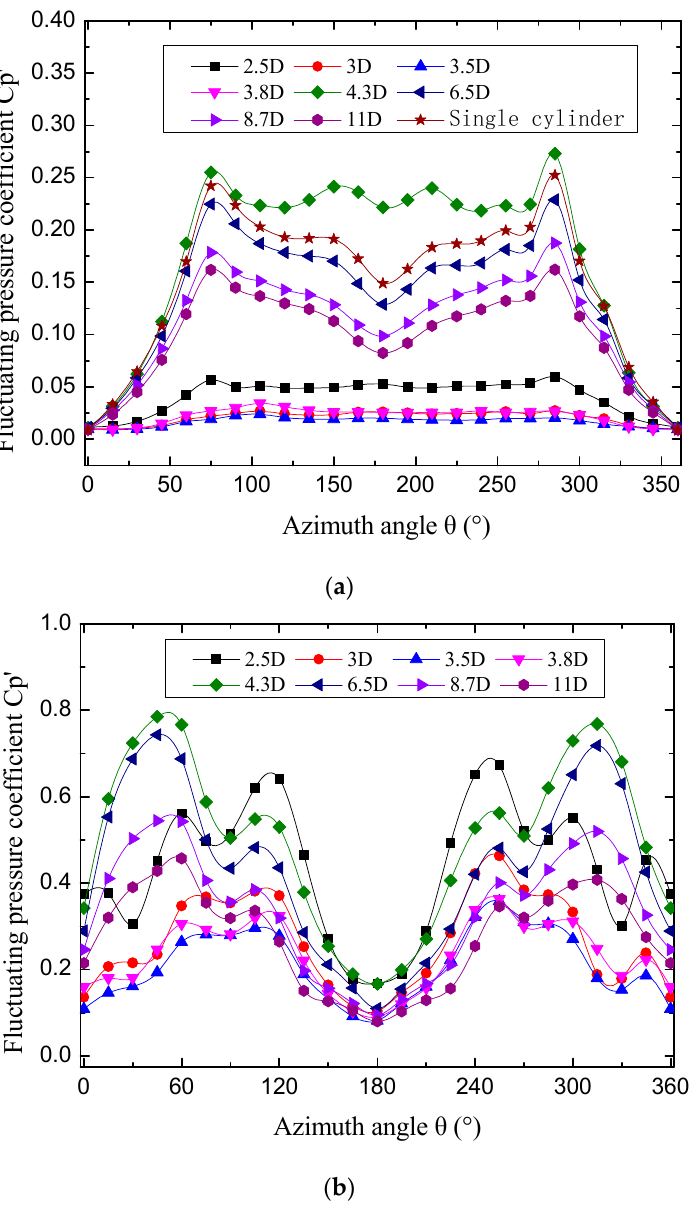
Figure 6. Distributions of fluctuating pressure coefficients on cylinders at α = 0°: ( a ) upstream cylinder; ( b ) downstream cylinder.